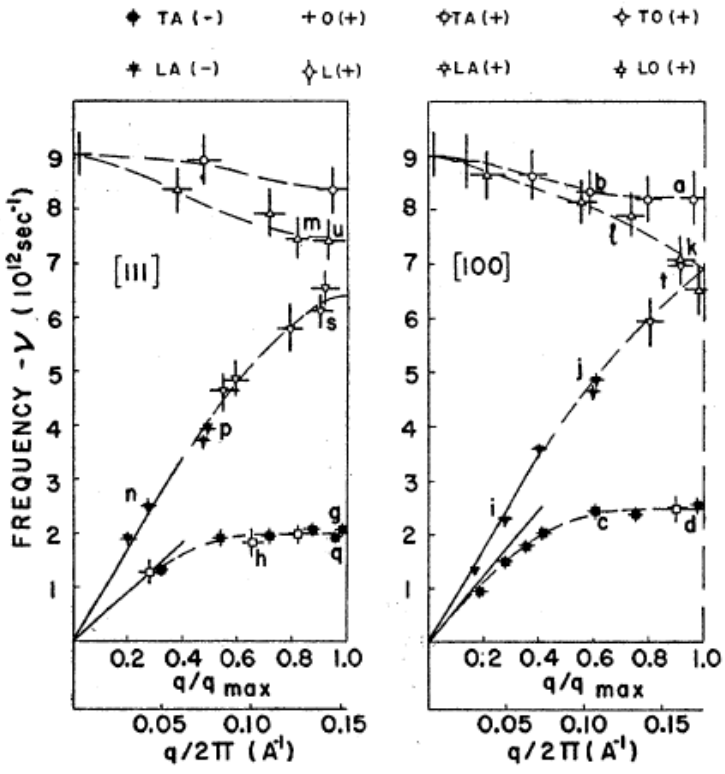
Figure 7. The phonon dispersion relations in the [ ζ 00] and [ ζζζ ] directions for germanium at room temperature. The legend at the top of the diagram indicates the polarization and character of the vibrations. The signs indicate neutron energy loss ( − ) or gain (+). The heavy lines near ( q /2 π ) = 0 indicate the slope of the appropriate velocities of sound as calculated from the elastic constants. This figure is taken from Figure 5 of ref. [27]. Copyright by the American Physical